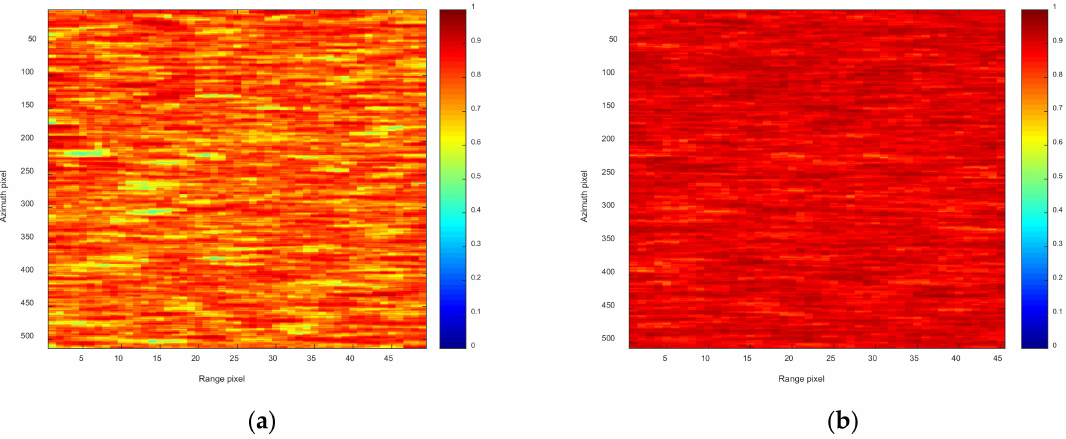
Figure 11. ( a ) Coherence of ideal InSAR (HH). ( b ) Coherence of PolInSAR with MCRE and polarization